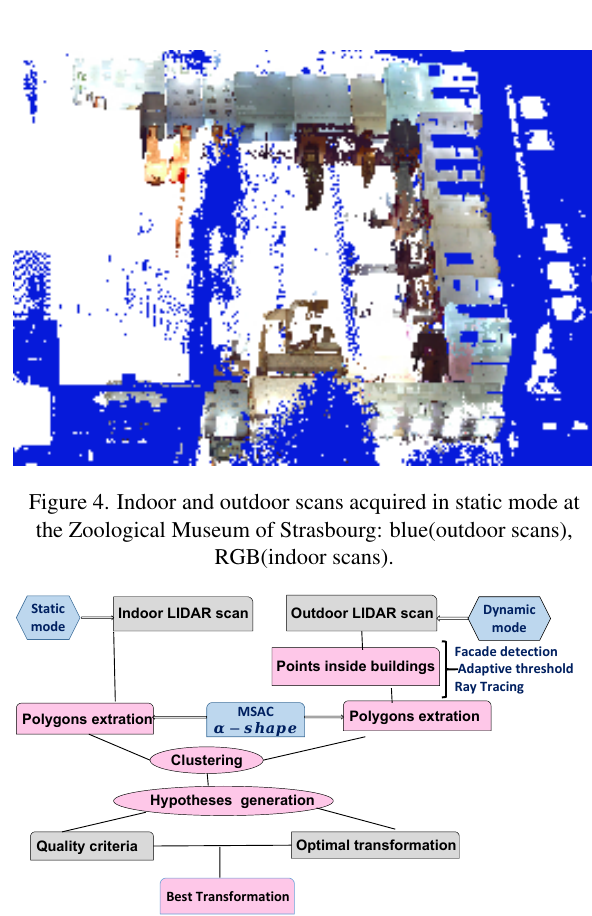
Figure 5. Pipeline Details